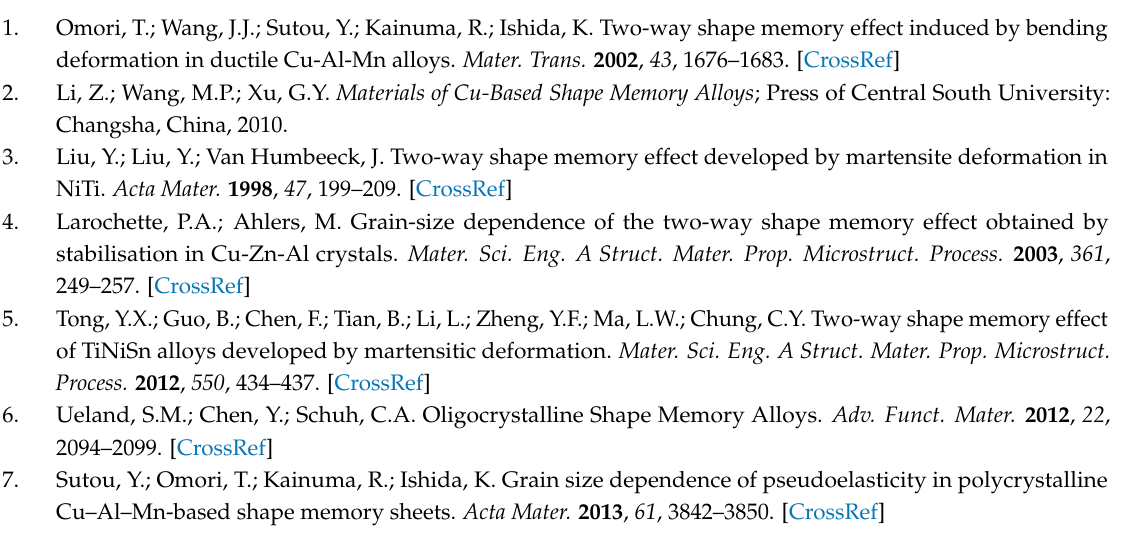
Figure 13. The morphology of martensite plates were observed at room temperature in the samples after different cryogenic pre-deformations; ( a – h ) were pre-deformation strains of ~2%, 3%, 4%, 5%, 6%, 8%, 10% and 12% respectively.